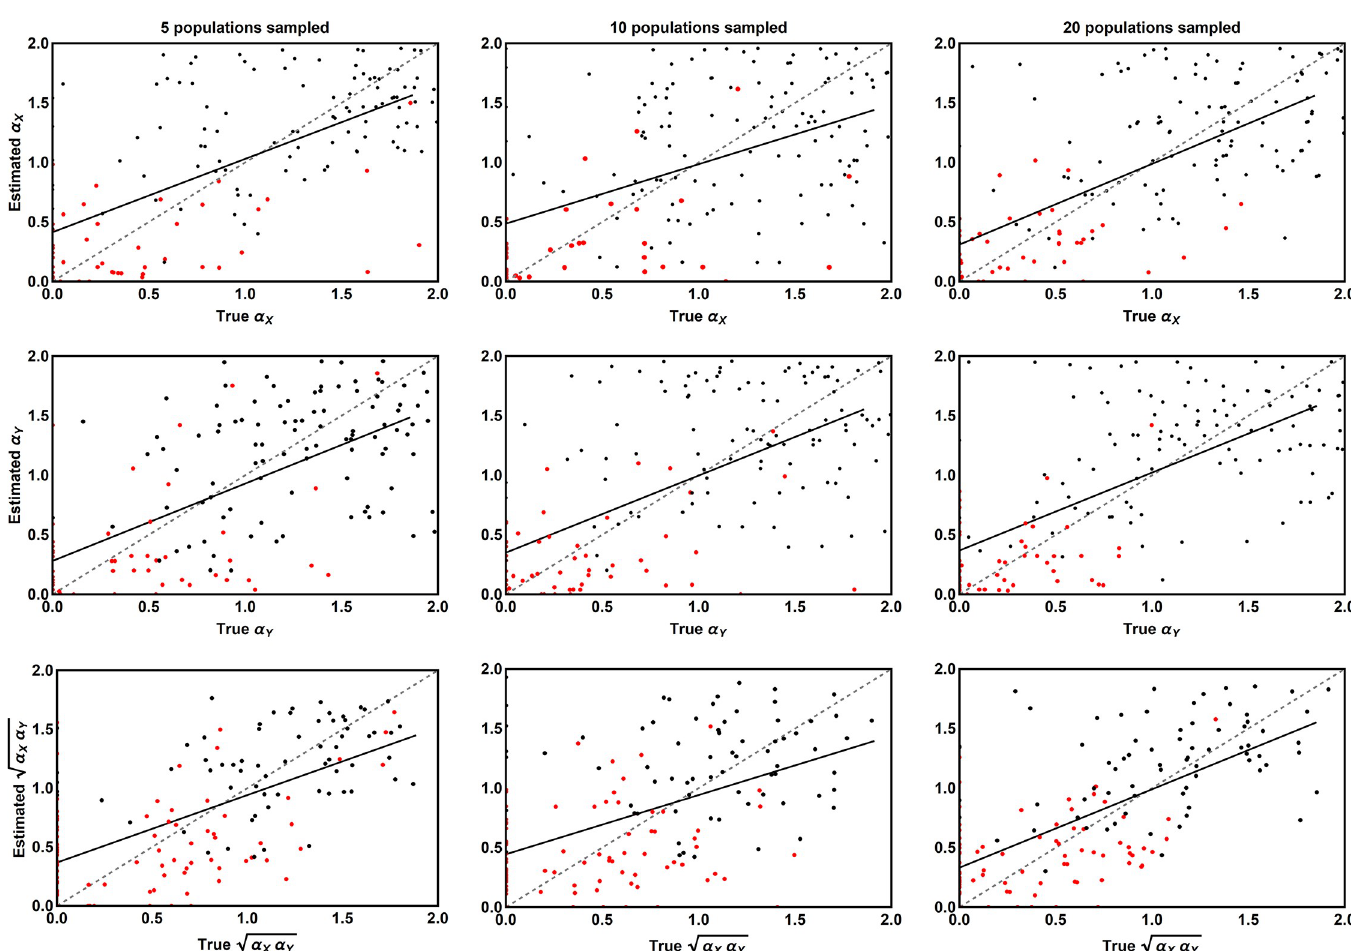
Fig 1. The relationship between the coevolutionary sensitivities used to simulate data (X axis) and the values of these parameters estimated by our ABC method (Y axis) for scenarios where independent estimates of background parameters are unavailable, necessitating the use of relatively broad prior distributions. The left- hand column shows results for cases where only 5 populations have been sampled, the center column cases where 10 populations have been sampled, and the right column cases where 20 populations have been sampled. Red points indicate parameter estimates for which the associated credible interval did not include zero. Black points indicate parameter estimates with credible intervals overlapping zero. The solid black line is the best linear fit and the dashed gray line is the perfect one to one relationship expected if all estimates were equal to their true values.